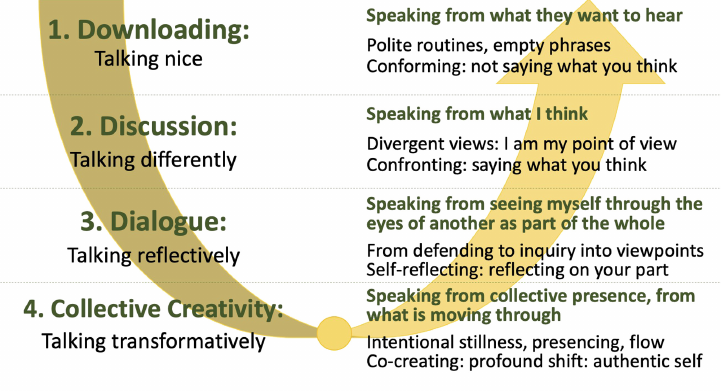
Figure 1. Levelsofconversations according to Theory